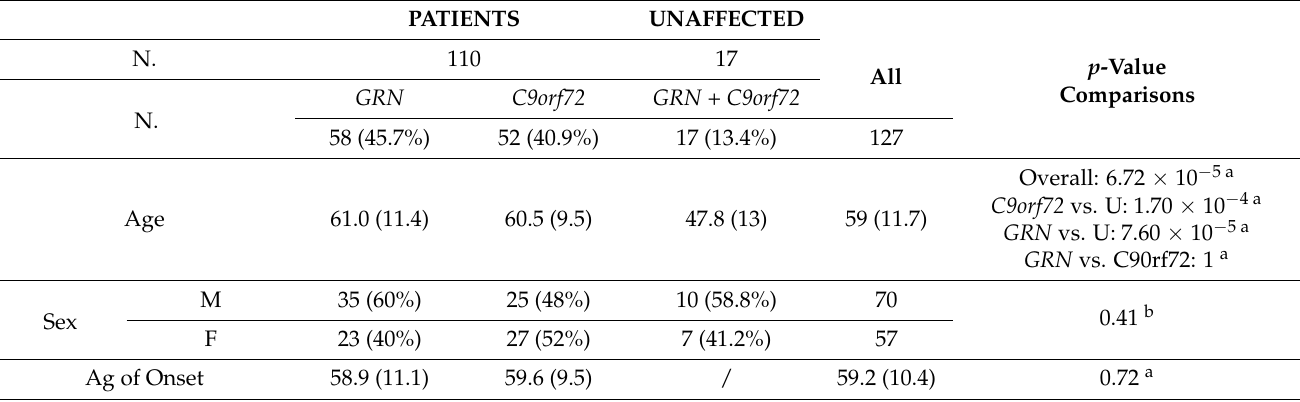
Table 1. Clinical and demographic characteristics of subjects included in the study. PATIENTS